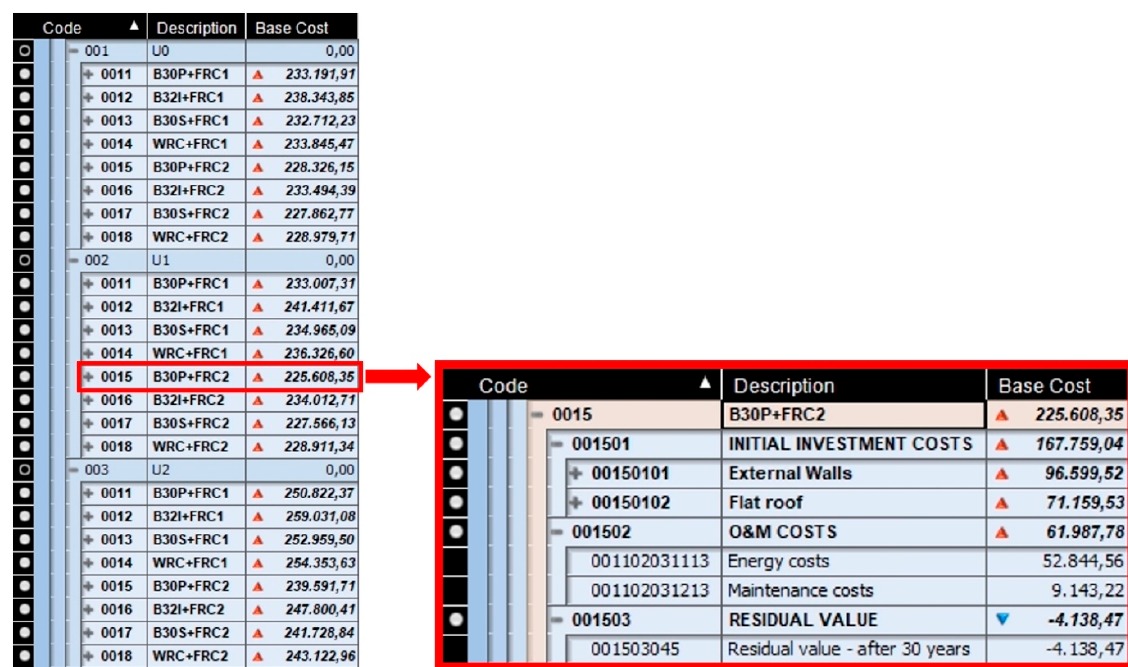
Figure 6. Results of a cost analysis in program VO for all variants and broken down by elements of LCC for variant B30P + FRC2 at U 1 .